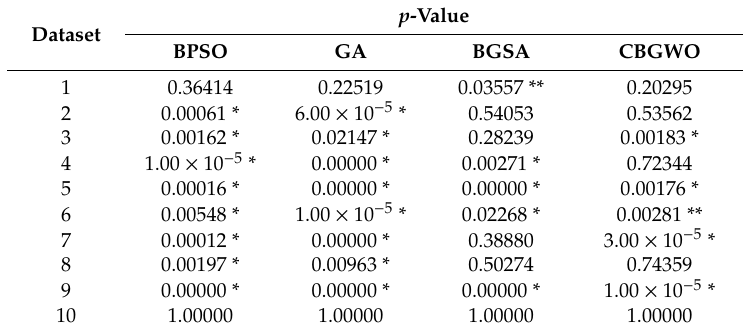
Table 4. The result of t ‐ test with p ‐ values (The CBPSO ‐ MIWS is used as reference algorithm). Dataset